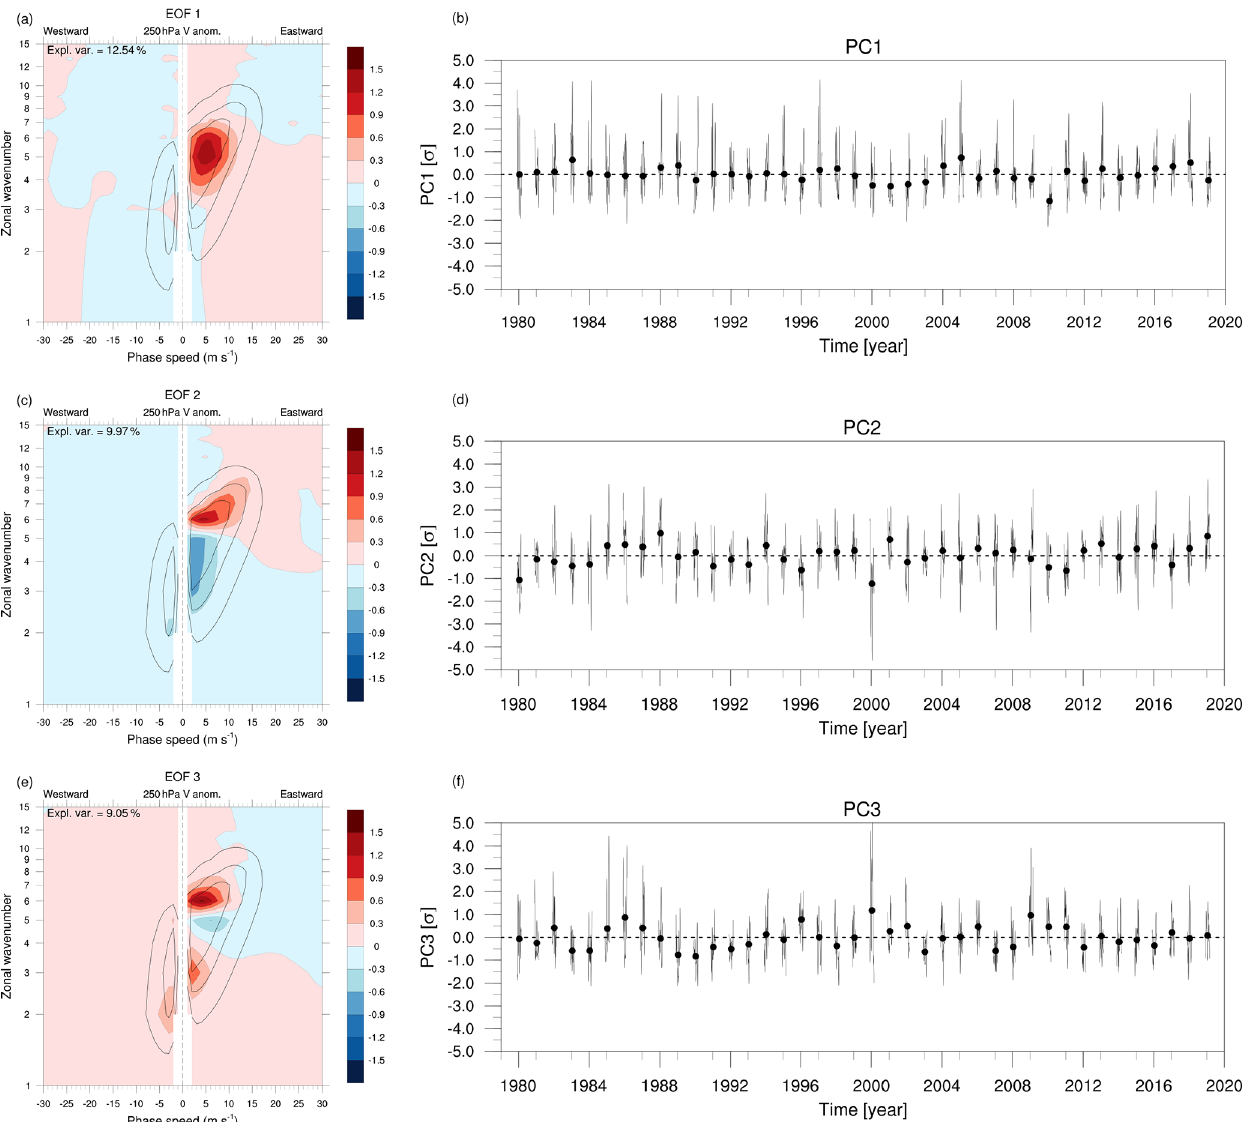
Figure 2. (a, c, e) Loadings of the first three EOFs of daily spectral anomaly during DJF (shaded, arbitrary units). The climatological spectral power is overlaid (black contours as in Fig. 1; only the 0.2, 0.4 and 0.6ms − 1 (cid:49)c − 1 levels). (b, d, f) Principal components associated with each EOF